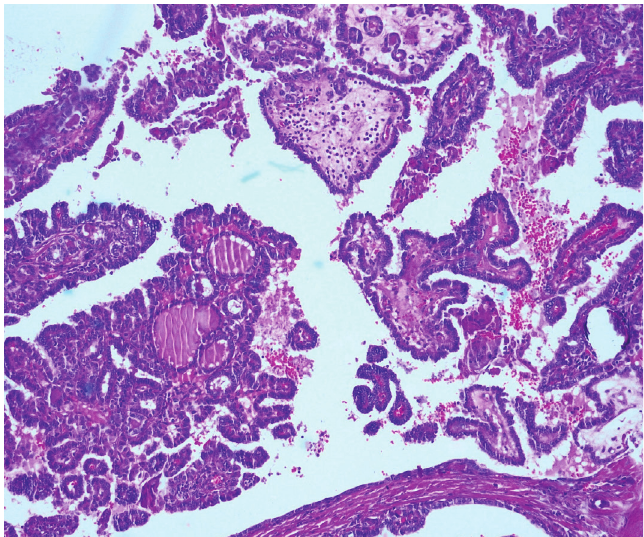
Figure 1 A - The papillary carcinoma.(HEx100)